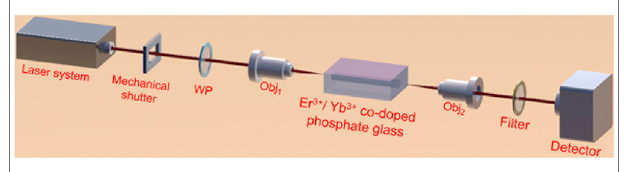
FIGURE 2 | The schematic plot of the end-face coupling system using a laser source at 632.8 nm.